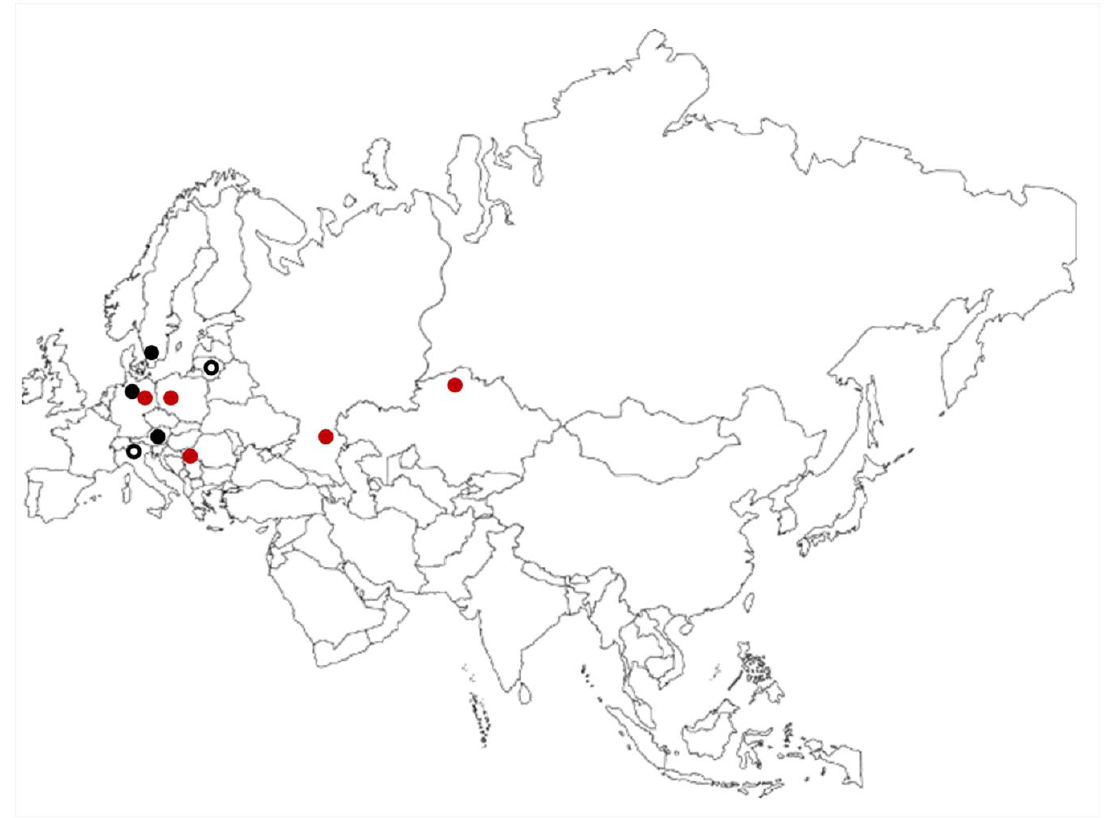
Figure 3. Distribution of C. baueri across Eurasian continent: Red circles—recent findings, new discovery or rediscovery. Black circles—reliable historical findings. Empty black circles—historical records which could not be confirmed or verified.